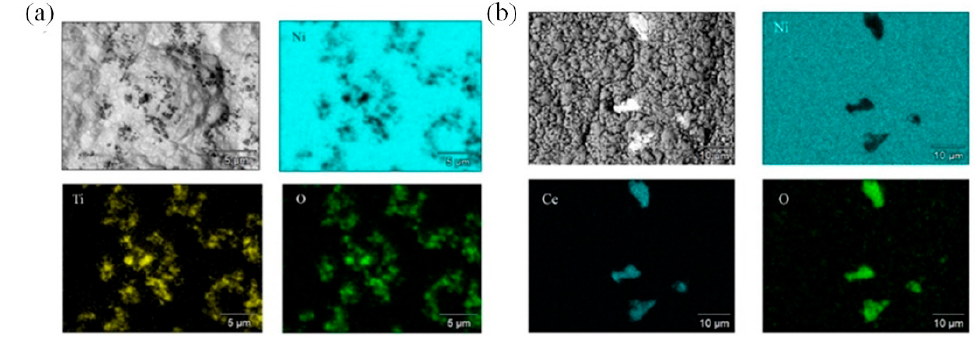
Figure 4. High-resolution EDX elemental mapping of the main elements in Ni-TiO 2 ( a ) and Ni-CeO 2 ( b ) coatings.